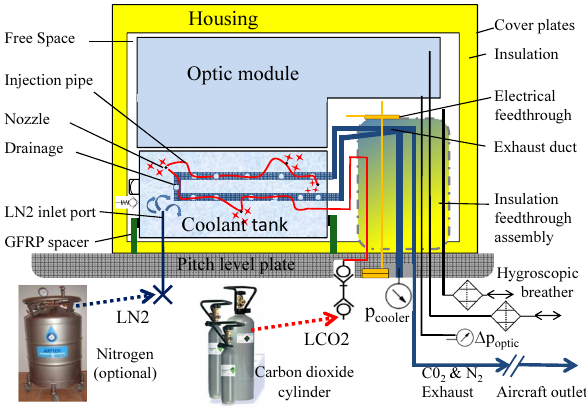
Figure 8. Functional thermal setup of the GLORIA spectrometer. Injection of liquid CO 2 allows charging dry ice through in situ pro- duction of CO 2 snow in the coolant tank. Alternatively controlled cooling is possible by injecting small amounts of liquid CO 2 or liq- uid N 2 .